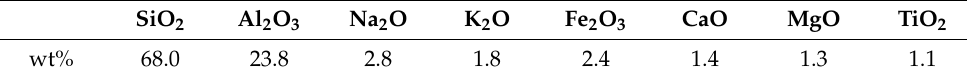
Table 3. Chemical composition of the spent pot lining aluminosilicates determined using